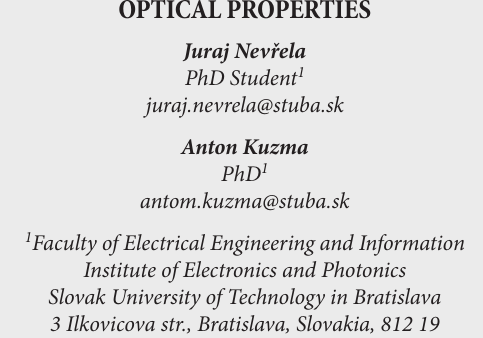
Fig. 3, а . The statistic function was applied to calculate the height of nanostructure which is in average 34 nm. The sta- tistic function is shown in Fig. 3, b . Surface roughness after etching was estimated on 3 nm at the bottom and 4,2 nm at the top of structure, which are comparable to roughness before this technological